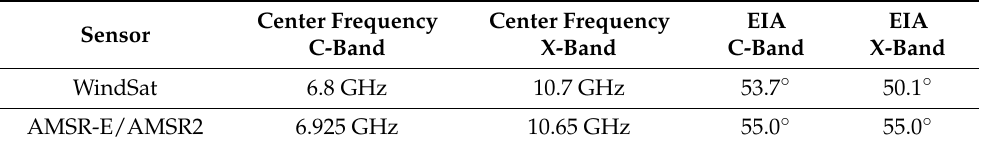
Figure 6. TC wind speed retrievals of the AMSR-E passes over Hurricane KATRINA on 2005/08/28 07:32 UTC. The full lines are the TC-wind contours of the 17.5 m/s (34 kt, gale-force), 25.7 m/s (50 kt, storm force) and 33 m/s (64 kt, hurricane force) winds. The dashed lines indicate the gale-force and storm force radii in the 4 quadrants (NE, SE, SW, NW) from the Best-Track (BT) data provided by the US National Hurricane Center (see the discussion in Section 3). Table 2. Values of the center frequencies and nominal Earth Incidence Angles (EIA) for the WindSat and AMSR C-band and X-band